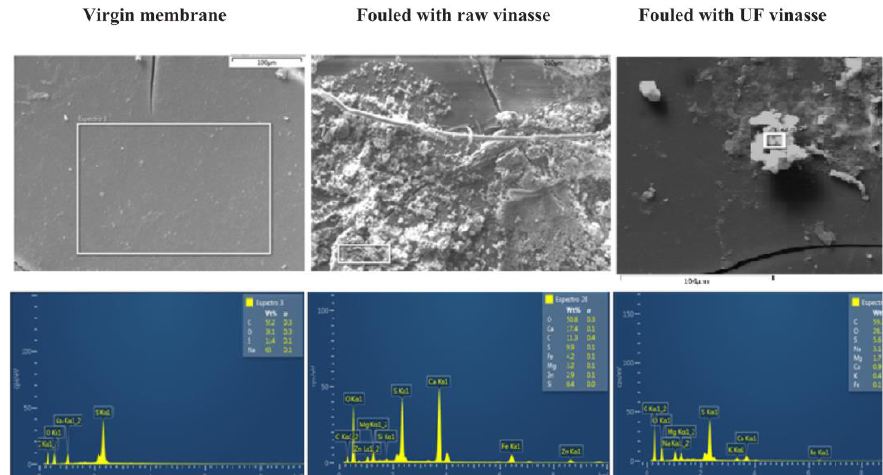
Figure 9. SEM micrographs and EDS (energy dispersive spectroscopy) analysis of cationic virgin membrane, membrane fouled with raw vinasse, and membrane fouled with ultrafiltrated vinasse. Reprinted with permission from Ref. [74]. Copyright © 2019 Elsevier B.V.